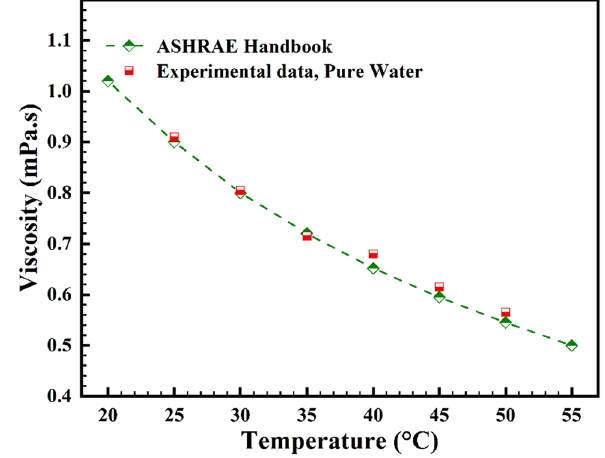
Figure 10: Viscosity vs distilled water temperature compared to that in ASHRAE handbook [ 53 ] .